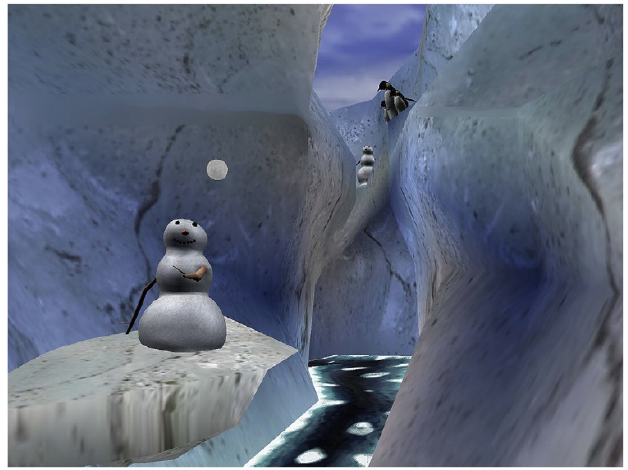
Figure 1. In SnowWorld, patients “go into” an icy canyon, where they throw snowballs at penguins, snowmen and other characters in VR. Image by Ari Hollander and Howard Rose, copyright Hunter Hoffman, www.vrpain.com accessed on 5 December 2021.